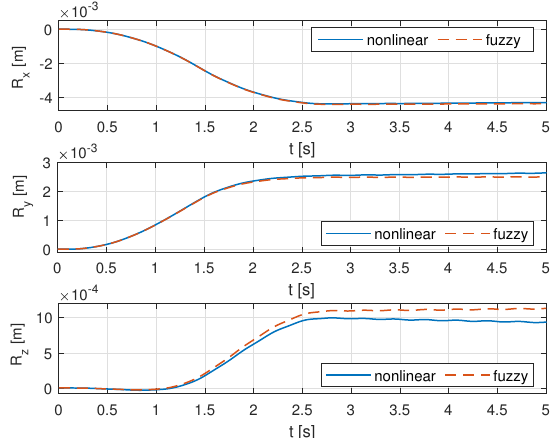
Figure 4. Position of the center of mass.